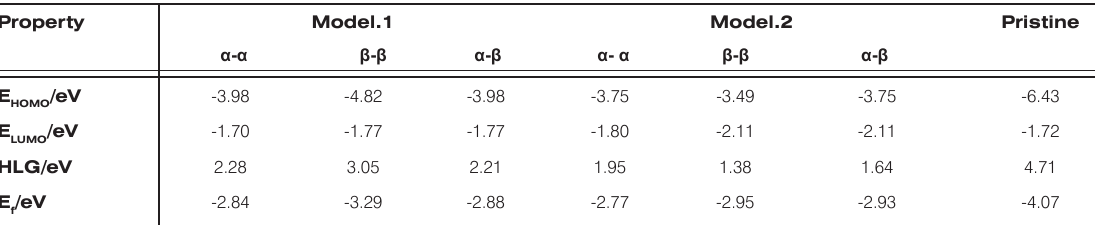
Table 3. Quantum molecular descriptors representive of models of AlNNTs.